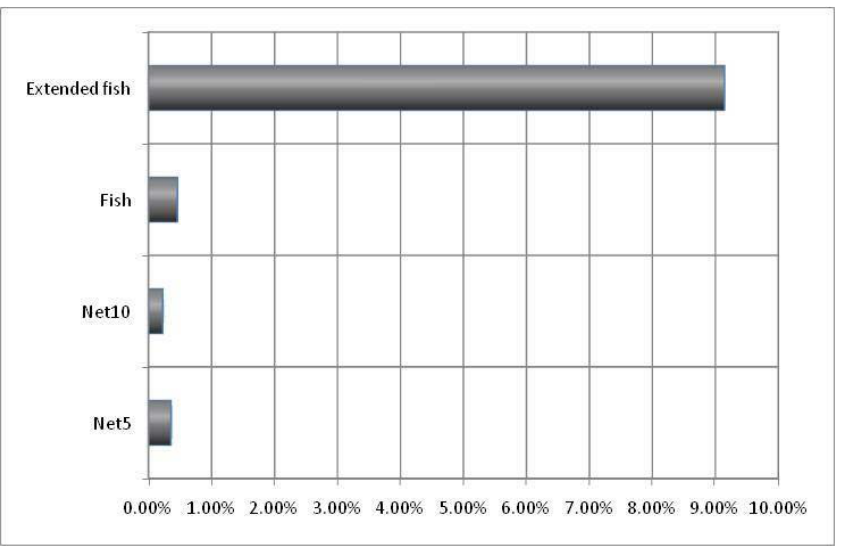
Figure 11. The pre-processing index